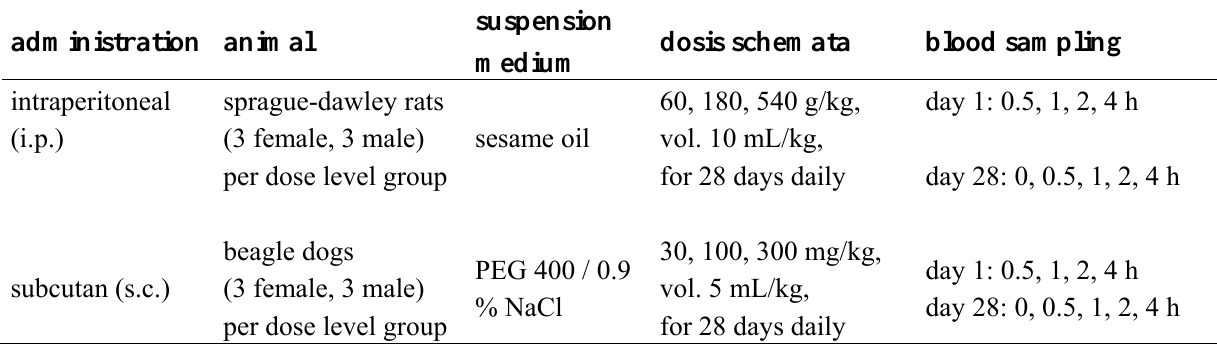
Table 2 . Dose schedules of TE for the determination of BE in